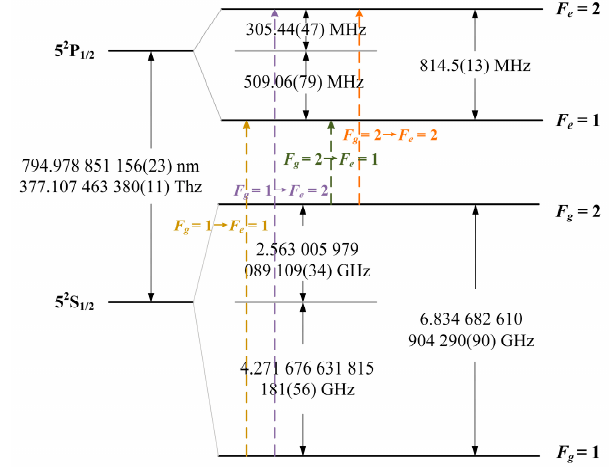
Figure 2. The schematic of the 87 Rb transitions between the hyperfine levels of the ground and excited states of the D1 transitions. A Table 1. Relative strengths → of the individual D1 hyperfine resonances for photon g e F F absorption.